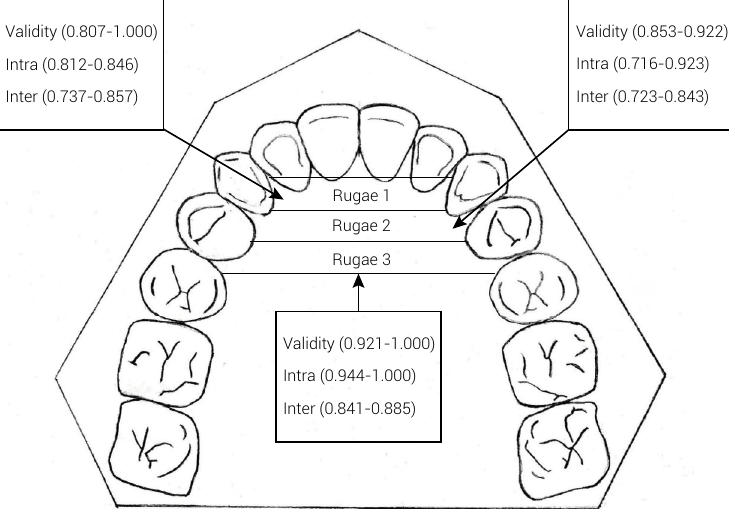
Figure 5. A diagram illustrating kappa values of validity, in addition to intra- and inter-examiner